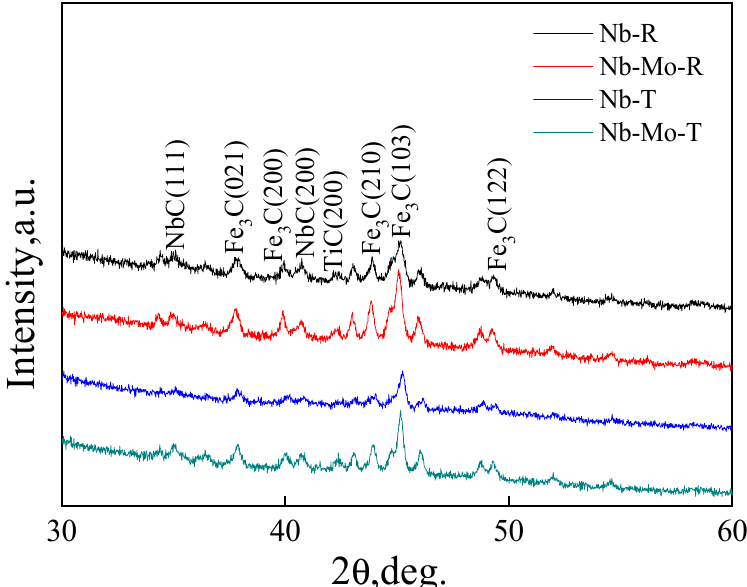
Figure 8. XRD patterns of precipitates electrolytically extracted from Nb and Nb-Mo steels before and after tension at 600 °C.